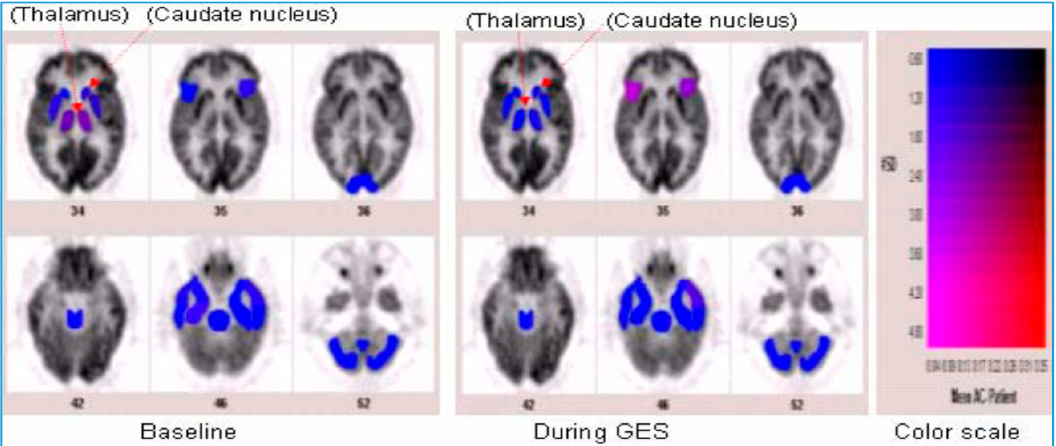
Figure 4. Results of positron emission tomography (PET) images of a brain before (left panel) and during (right panel) gastric electrical stimulation (GES) at a 3-month follow-up visit. These images represent differences in centrally acting anti-emetic areas identified by PET scan in the thalamus and caudate lobe associated with GES therapy. Reprinted by permission from [46].